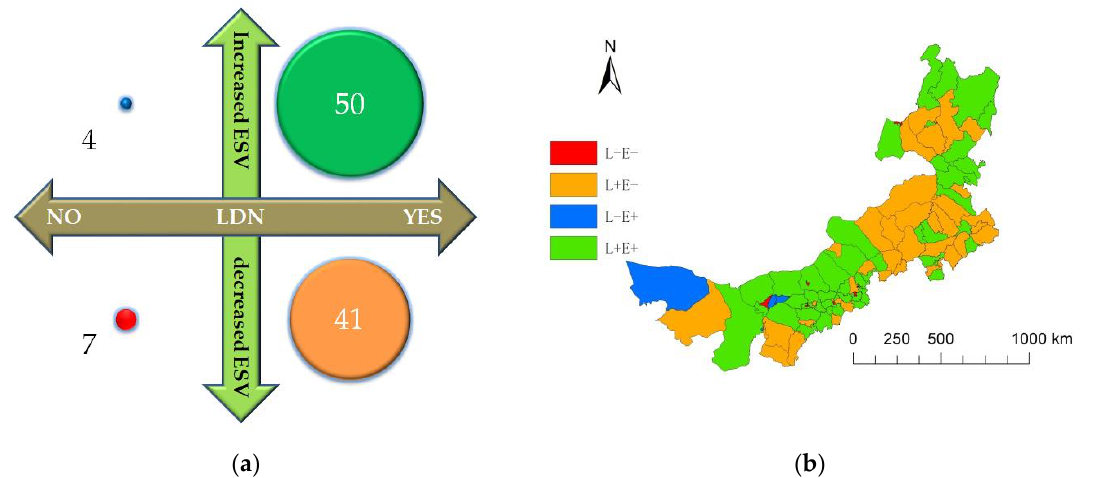
Figure 6. Relationship between LDN and ESV assessed by the number of counties ( a ) and spatial distribution ( b ). In ( b ), “−” represents the negative performance of LDN or ESV, while “+” represents the positive performance.